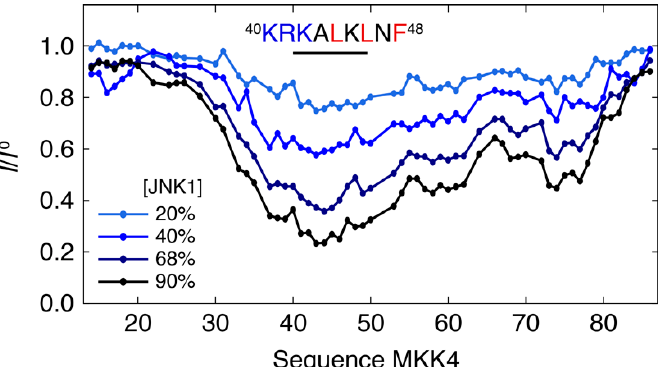
Figure 2. Intensity profile ( I / I 0 ) obtained by quantifying the NMR signal intensities in the 1 H- 15 N HSQC spectrum of the free state of MKK4 ( I 0 ) and of MKK4 with different molar ratios of JNK1 ( I ): 20%, 40%, 68% and 90%. The docking site motif of MKK4 encompasses residues K40-F48 (primary sequence is shown).